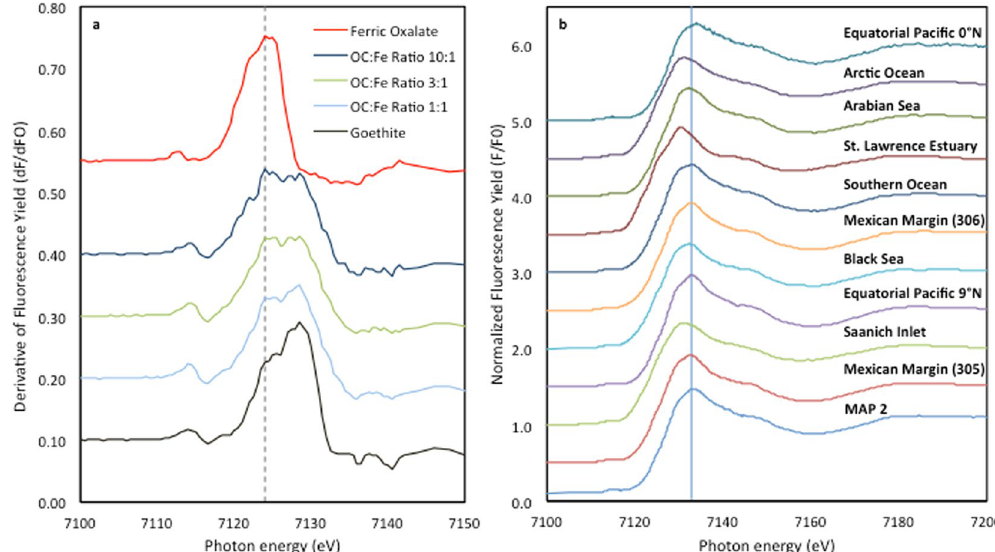
Figure 3. Iron K-edge spectra for the samples analyzed in this study. ( a ) First derivative of Fe 1 s XANES spectra for goethite, ferric oxalate and synthetic lepidocrocite with initial solution OC:Fe Molar ratios of 1, 3, and 10. The intersecting line at 7124.5 eV highlights the shift in absorbance maxima for ferric oxalate; ( b ) Normalized Fe 1s XANES spectra for raw sediments with the vertical line at 7132.8 eV representing the absorption maximum for